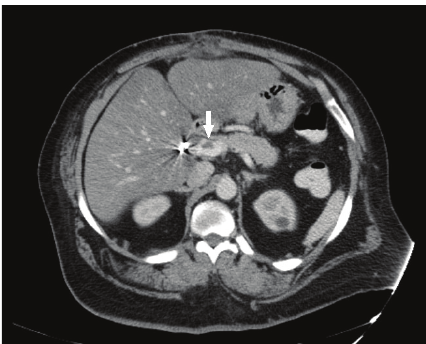
Figure 1: Computed tomography of abdomen and pelvis axial view showing portal vein thrombosis.